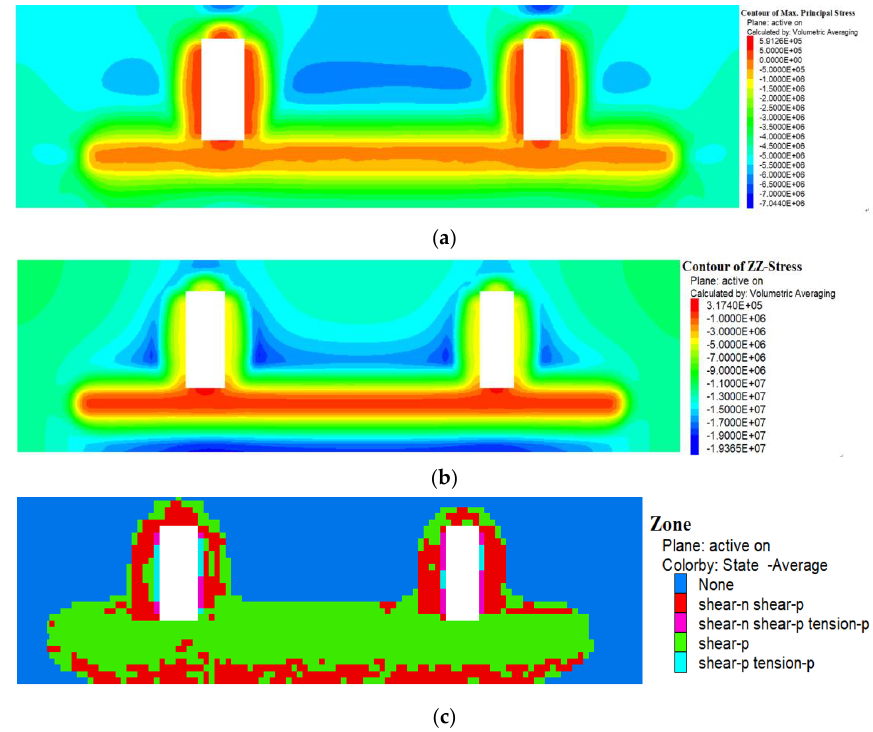
Figure 7. Surrounding rock variation characteristics for h = 5 m. ( a ) Maximum principal stress distribution; ( b ) vertical stress distribution; and ( c ) plastic differential distribution.